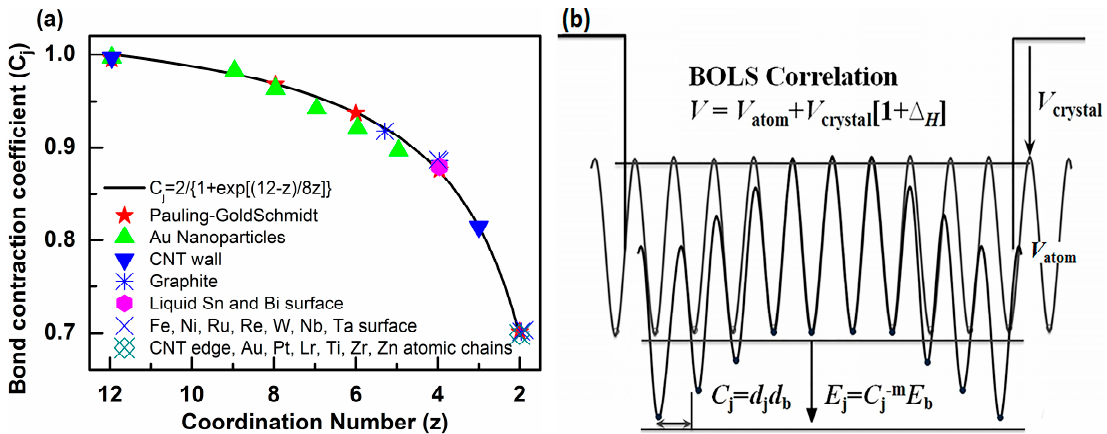
Figure 1. ( a ) The bond-order-length-strength (BOLS) approximation (solid line) represents the atomic “ CN -radius” convention of Pauling [33 ] and Goldschmidt [34 ] , with further evidence (scattered symbols) obtained from nanomaterials and surfaces; ( b ) Schematic illustration of broken bond-induced local strain and energy entrapment at the terminating edges, up to three atomic layers deep.